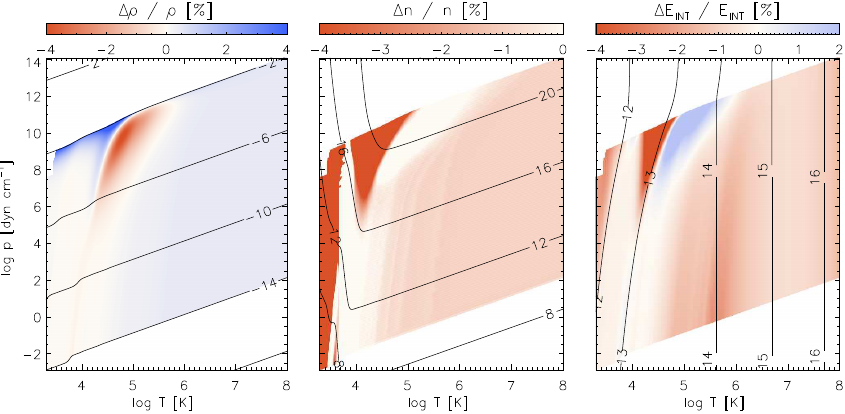
Figure 4. The relative difference between the VMW EOS and the OPAL EOS in the mass density, the electron number density and the internal energy ((VMW-OPAL)/VMW). The VMW EOS is computed on the T – p grid and the OPAL EOS computed on the T – ρ grid and then interpolated to the T – p grid. The two EOSs are computed for the same mass fractions. The contour lines are copied from Fig. 3 for